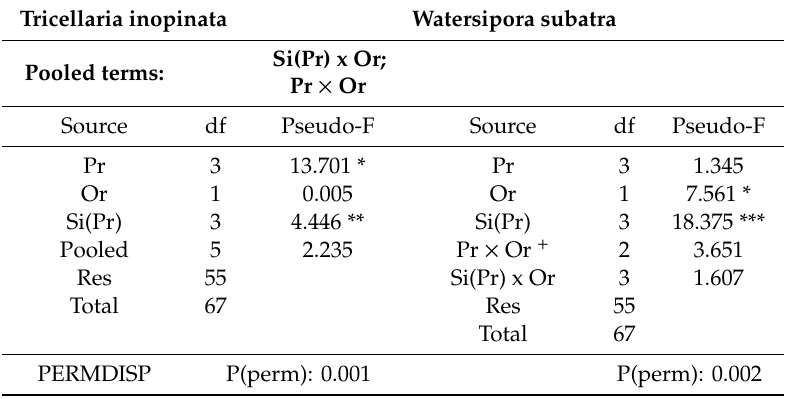
Figure 4. Mean ( + SE, per panel) total percentage cover of NIS showing di ff erences between ( a ) “Origin of biofilm” and ( b ) “Sites” ( n = 10), ( c ) taxonomic richness and ( d ) Shannon index (H’) of NIS showing di ff erences between “Sites” and “Origin of biofilm” ( n = 5, n = 10 for MPA). White bars, MPA biofilm; black bars, local biofilm. Table 9. Univariate analysis of variance of most conspicuous NIS across “Pressure” levels (Pr), “Origin of biofilm” (Or) and “Sites” (Si(Pr)) after 15 weeks of panel deployment. Analyses are based on Euclidean distances of square root transformed percent covers of Tricellaria inopinata and Watersipora subatra . Pair-wise comparisons were performed when significant di ff erences were found (see Supplementary Materials Table